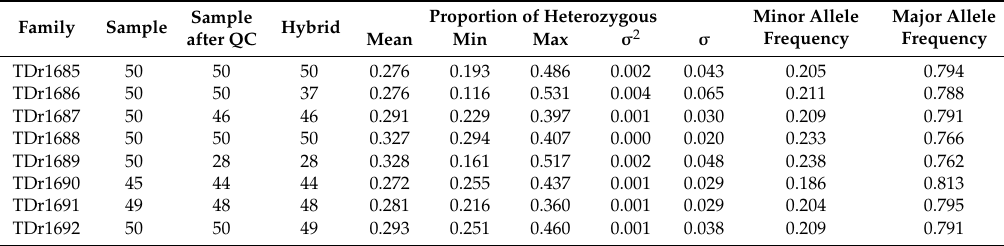
Table 1. Summary statistics: minor allele frequency, major allele frequency, proportion of heterozygosity, and QC = quality check of genetic (6602 SNPs, 394 individuals) of segregating progenies of white yam. Proportion of Heterozygous Minor Allele Family Sample Sample Hybrid Frequency after QC